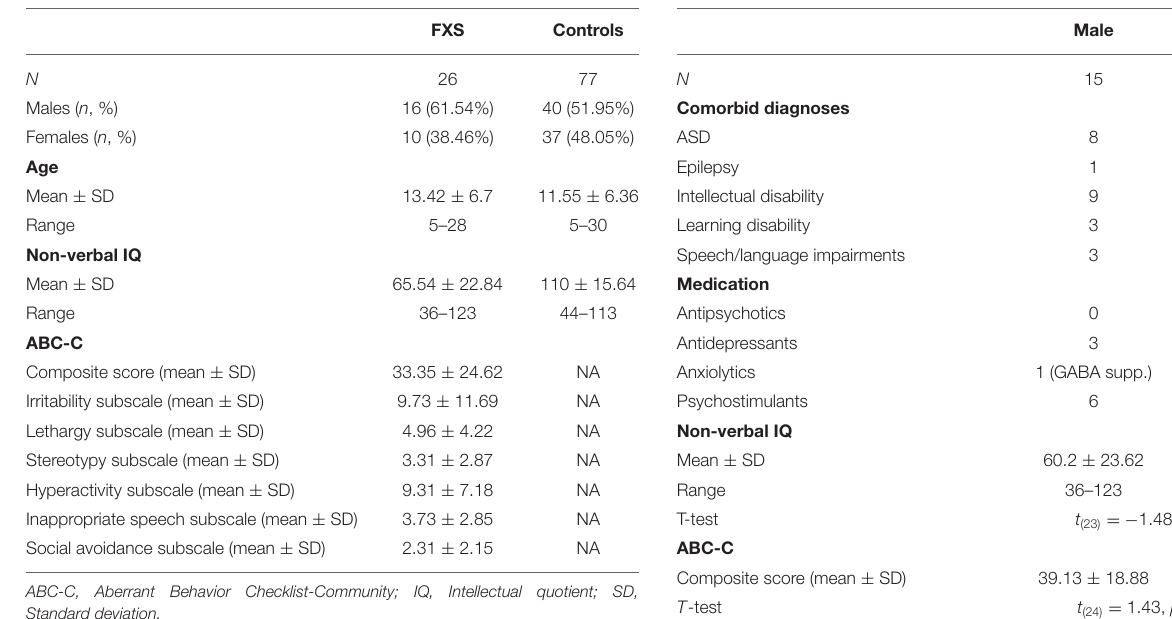
TABLE 1 | Demographics of the study population. TABLE 2 | Comorbid diagnoses and medication in the FXS